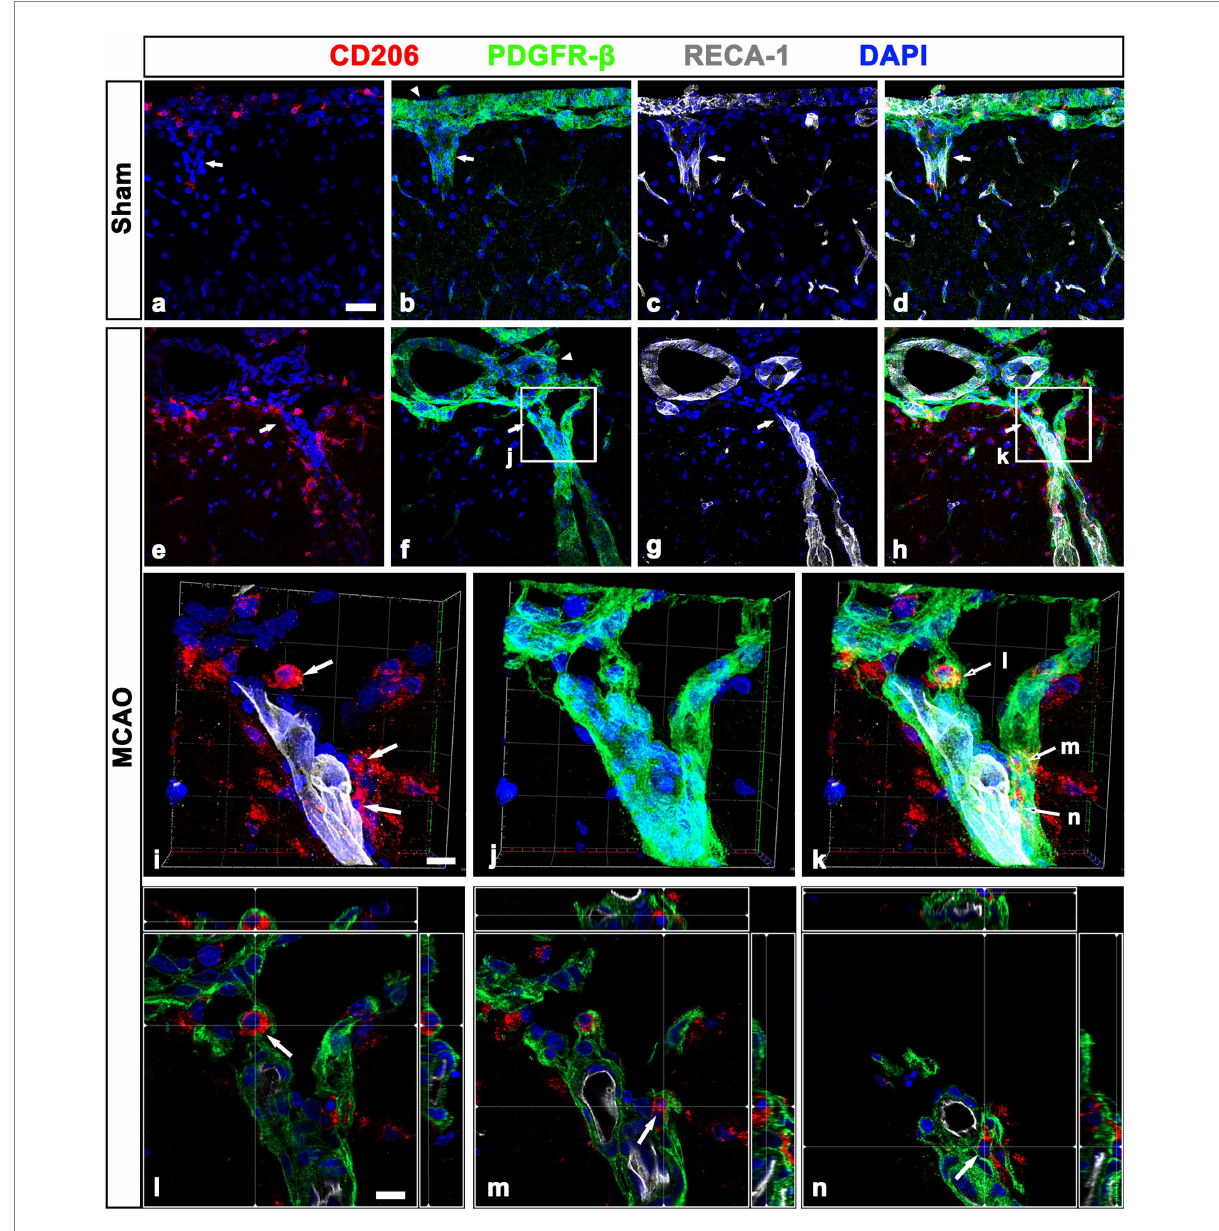
FIGURE 5 Relationship between leptomeningeal macrophages and PDGFR- β (+) cells within penetrating vessels in sham-operated and MCAO rats. (A–H) . Triple labeling for PDGFR- β , CD206, and RECA-1 in sham-operated (A–D) and MCAO rats at day 3 after reperfusion (E–H) . CD206-labeled macrophages are rarely observed in PDGFR- β -positive penetrating cortical vessels of sham-operated rats (arrows in A–D ), while several meningeal macrophages are noted within penetrating vessels (arrows in E–H ) in MCAO rats. Arrowheads in (B,F) indicate the leptomeninges. (I–K) The three- dimensional magnified images of boxed areas in (F,H) (penetrating vessels close to the cortical surface) showing that meningeal macrophages (arrows in I and K ) within penetrating vessels are localized in close proximity to PDGFR- β -positive cells. (L–N) Orthogonal views of three meningeal macrophages indicated by arrows in (I,K) , respectively, showing that they are located on the adluminal side of PDGFR- β -positive cells within penetrating vessels. Scale bar = 40 μ m for (A–H) ; 10 μ m for (I–N)